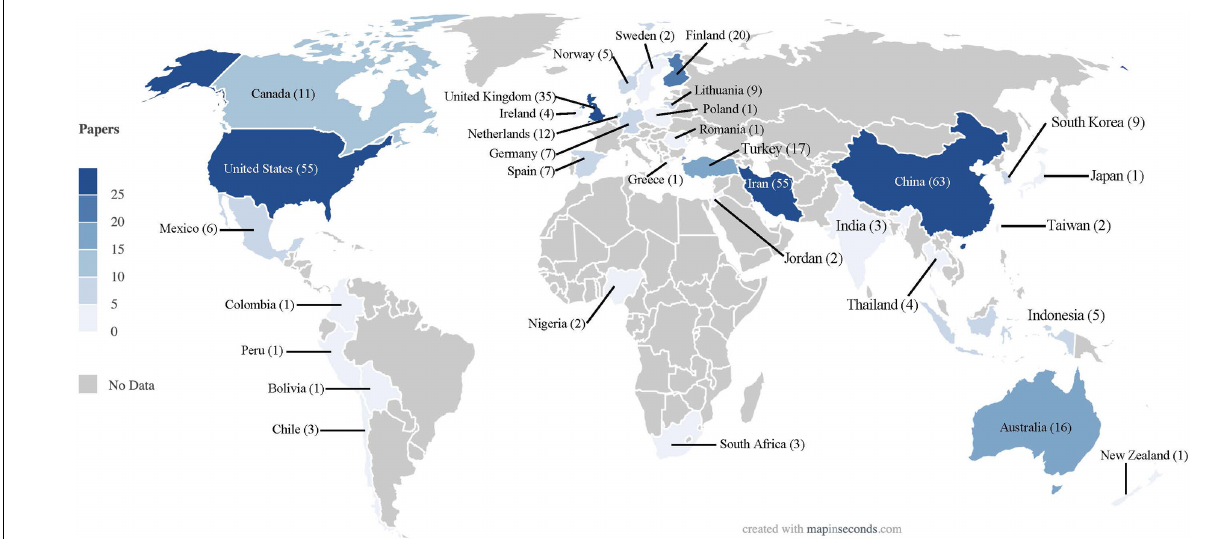
FIGURE 2 | Geographical distribution of selected publications.